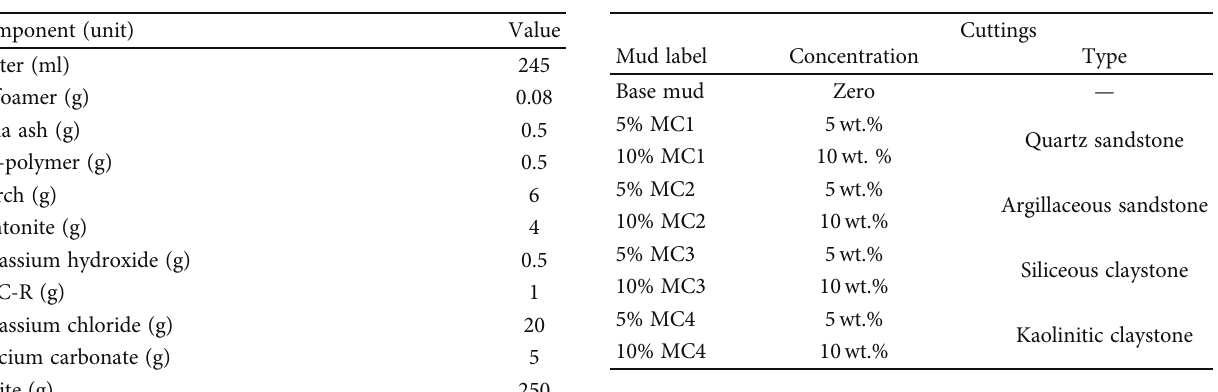
Figure 4: SEM microphotographs of the rock samples showing the dominant minerals, (a) quartz, (b) Kaolinite, and (c) hematite. Table 1: Base mud formulation. Table 2: Map for preparing the drilling fl